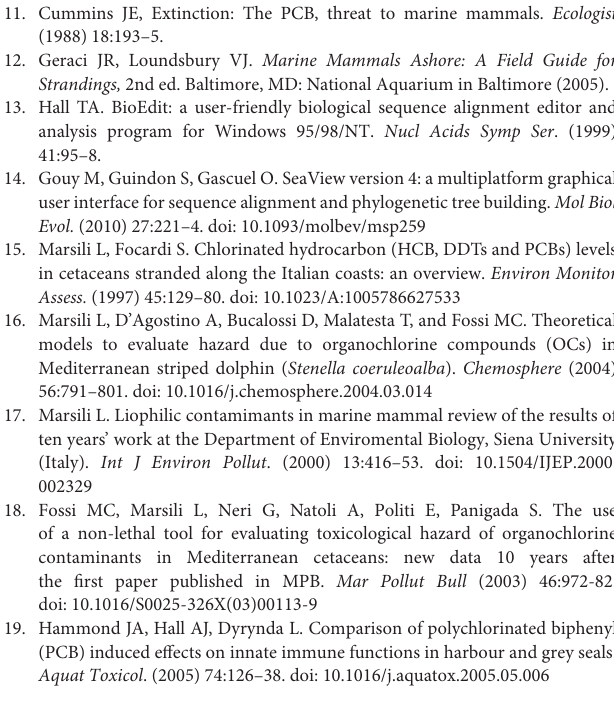
Figure S1 | Numerous round, up to 25 µ m, eosinophilic glassy structures (intracytoplasmic inclusion bodies) surrounded by a clear halo (Guarnieri bodies). Scale bar = 100 µ m. Figure S2 | Electron micrograph of skin lesion sample showing negatively stained brick viral particle of ≈ 150–310nm, consistent with Cetacean poxvirus. Scale bar =